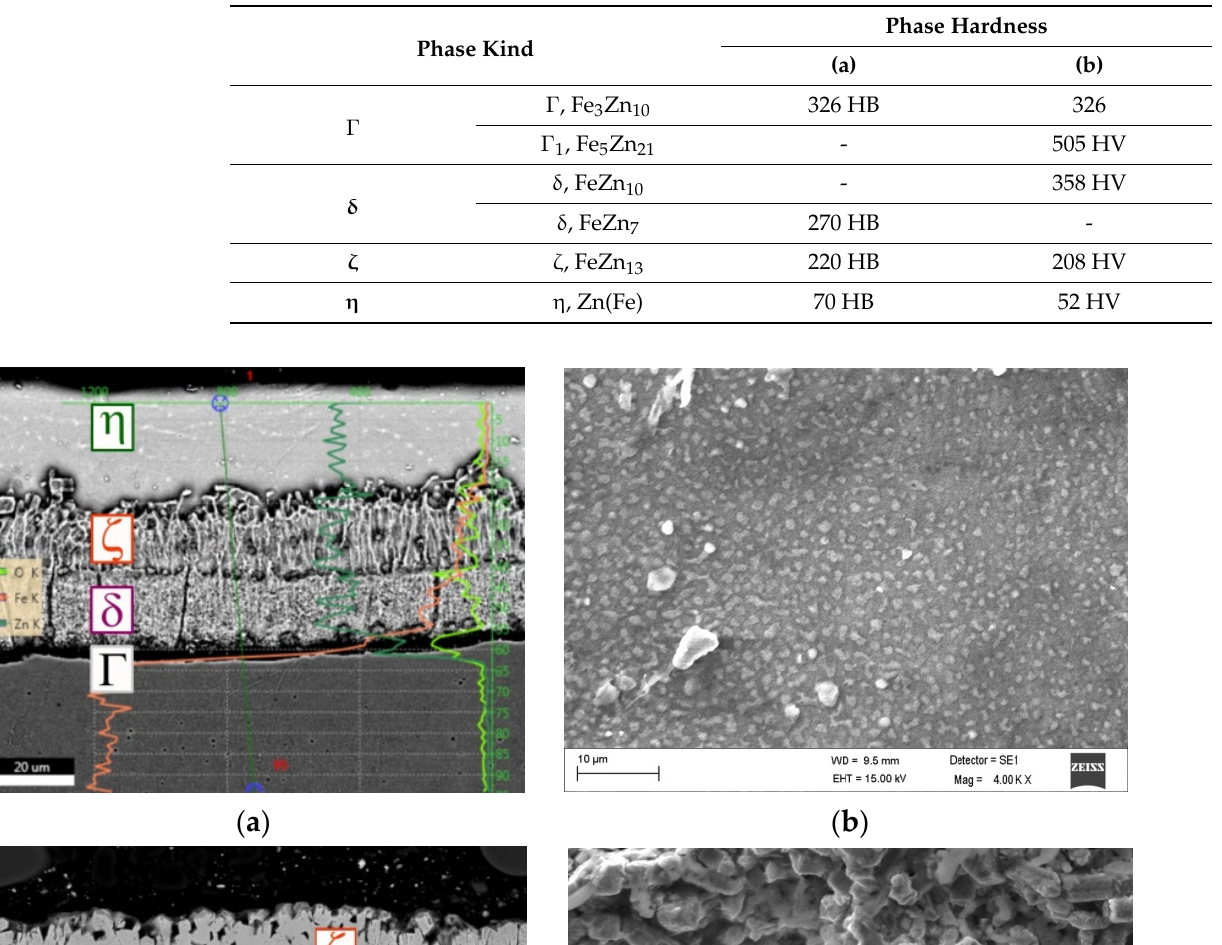
Table 2. Hardness of individual intermetallic phases of zinc coating deposited by hot-dip zinc galvanizing according to: Evans [8] ( a ) and Pokorný et al. [55] ( b ).